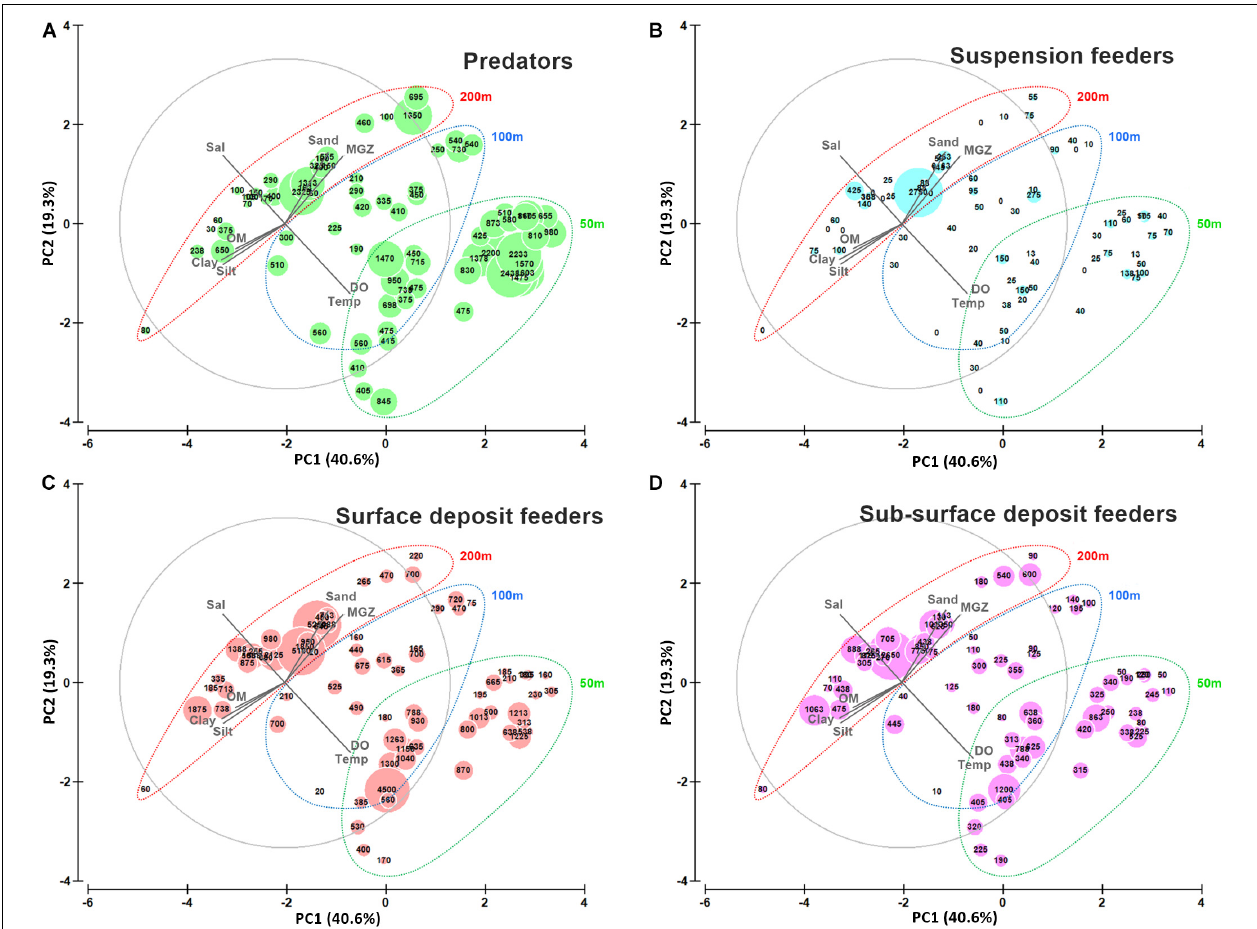
FIGURE 11 | Principal Component Analysis (PCA) bi-plot with superimposed bubbles indicating abundance of polychaete feeding guilds at 50, 100, and 200 m depth strata. (A) predators (B) suspension feeders, (C) surface deposit feeders and (D) sub-surface deposit feeders with respect to environmental parameters (arrows: Temp-Temperature, Sal-Salinity, DO-Dissolved oxygen, Sand, Silt, Clay, MGZ-Median grain size, OM-Organic